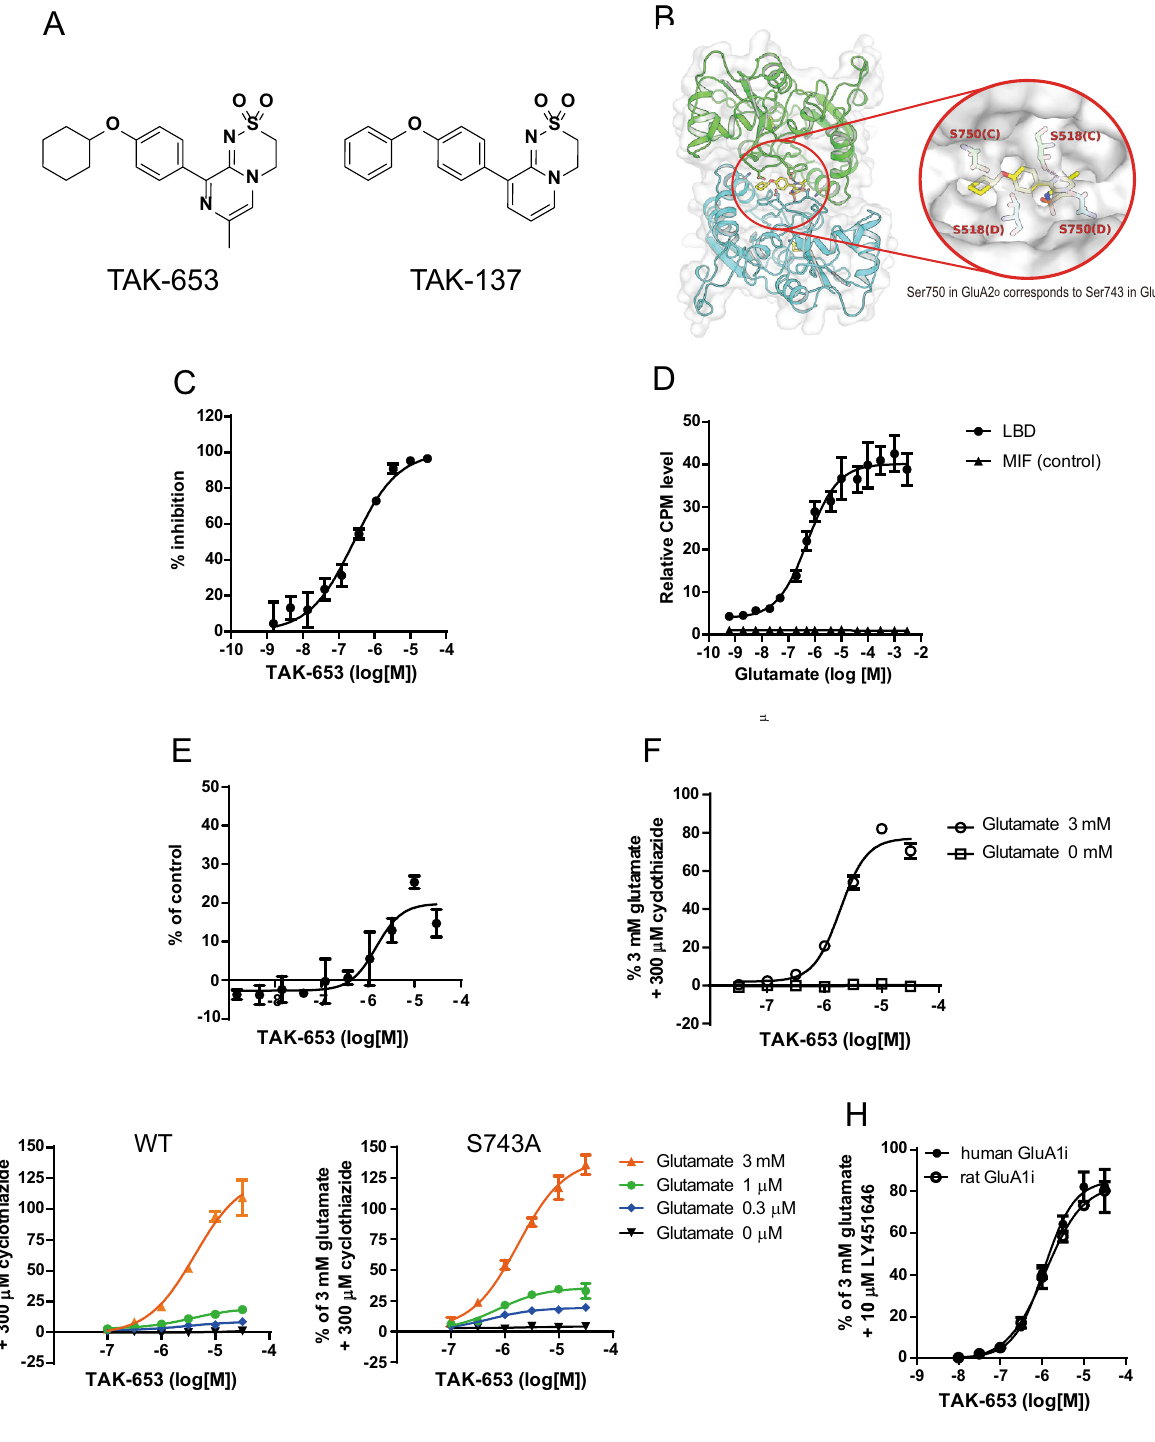
Figure 1. Selective binding of TAK-653 to AMPA-R in a glutamate-dependent manner. ( A ) Chemical structure of TAK-653 and TAK-137. ( B ) The GluA2 (flop)/glutamate/TAK-653 complex crystallized as a dimer. ( C ) Displacement studies with TAK-653 using the SPA assay with [ 3 H]-HBT1 and His-LBD. Data are represented as mean ± SD (n = 4). ( D ) Effects of glutamate on the binding of [ 3 H]-TAK-653 to His-LBD. Data are represented as relative value ± SD in counts per minute (CPM) (n = 3). ( E ) Effect of TAK-653 on the binding of [ 3 H]-AMPA to His-LBD. Data are represented as mean ± SEM (n = 4). ( F ) Effects of TAK-653 on Ca 2+ influx in GluA1i CHO cells in the presence (open circle) and absence (open square) of 3 mM glutamate. Data are represented as mean ± SD (n = 3). ( G ) Effects of TAK-653 on Ca 2+ influx in CHO cells expressing GluA1i WT or GluA1i S743A in the absence or presence of glutamate (0.3 μM, 1 μM and 3 mM). S743 in GluA1i LBD corresponds to S750 in GluA2o LBD. Data are represented as mean ± SD (n = 3). ( H ) Effects of TAK-653 on Ca 2+ influx in hGluA1i CHO cells (closed circle) and rGluA1i CHO cells (open circle) in the presence of 3 mM glutamate. Data are represented as mean ± SD (n =